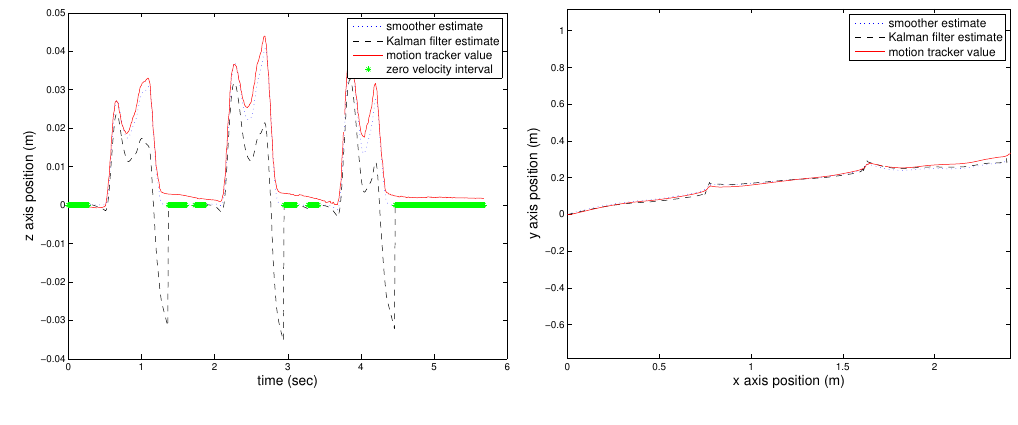
Figure 3. Estimated position with the flat floor assumption: z -axis position ( Left ) and xy -axis position ( Right